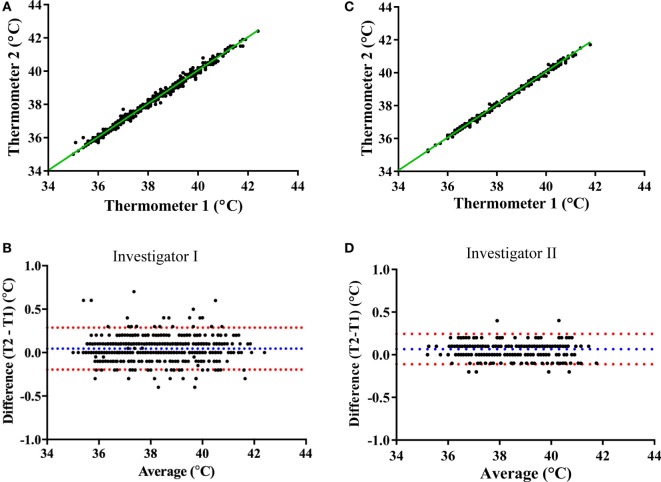
Mercury thermometer bias as measured by each investigator on separate occasions. The top panels compare the temperature readings from the Hg thermometers 1 and 2 (Thermo 1 vs. Thermo 2) across the range of 35–40°C by investigator I (A) or by investigator II (C); the dashed green lines being the lines of identity. The bottom panels show Bland–Altman plots of the difference vs. average of readings from the two Hg thermometers (T1 and T2) made by investigator I (B) or investigator II (D); blue and red dashed lines indicate the mean bias and limits of agreement, respectively.